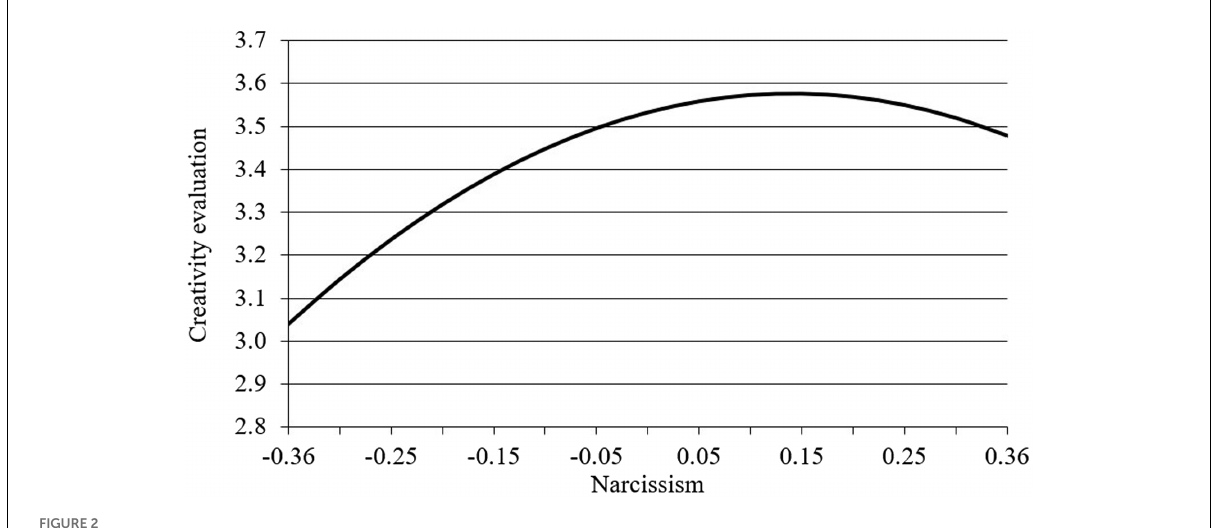
FIGURE 2 The relationship between narcissism and creativity